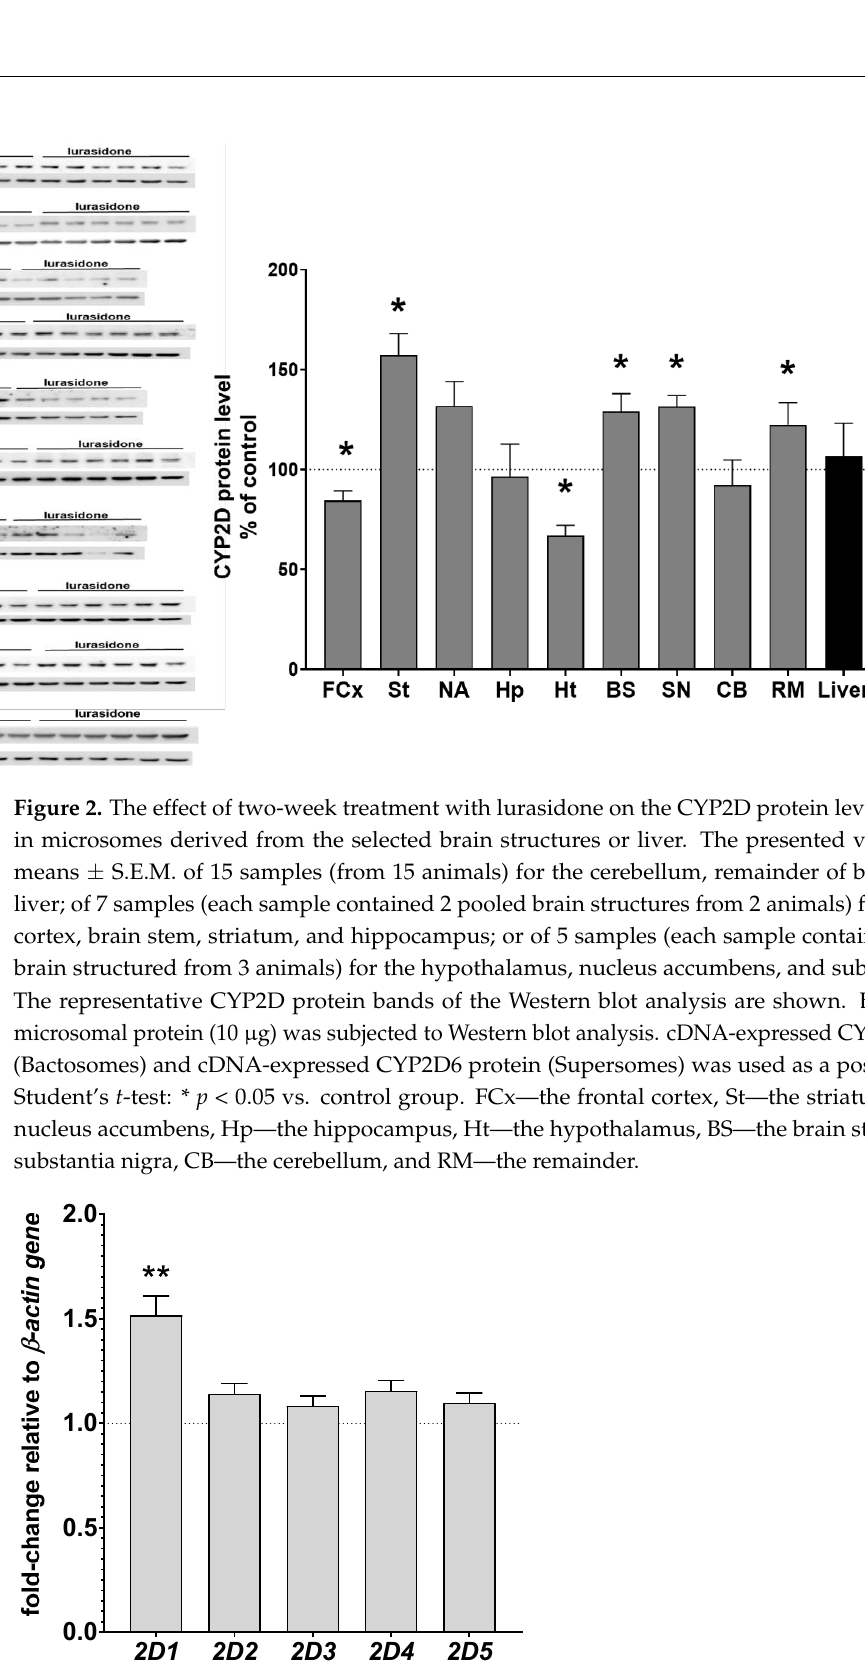
Figure 3. The influence of two-week treatment with lurasidone on the mRNA levels of the CYP2D1 , CYP2D2 , CYP2D3 , CYP2D4 , and CYP2D5 genes in the liver. The results are expressed as the fold change compared to the ACTB housekeeping gene. The presented values are the mean fold change quantified by the comparative delta–delta Ct method for the control and lurasidone-treated rats (mean ± S.E.M. of 10 sample). Student’s t -test: ** p < 0.01 vs. control group.